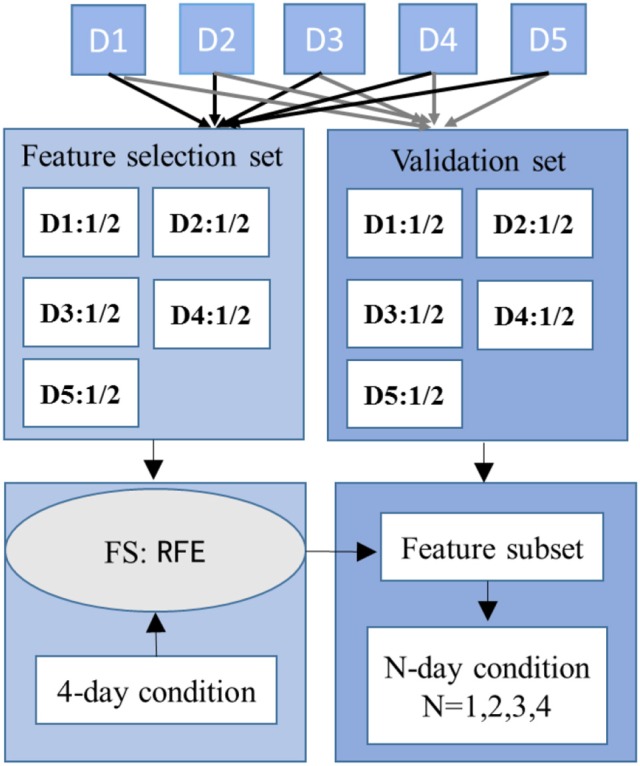
The illustration depicts a fold of the feature selection procedure.